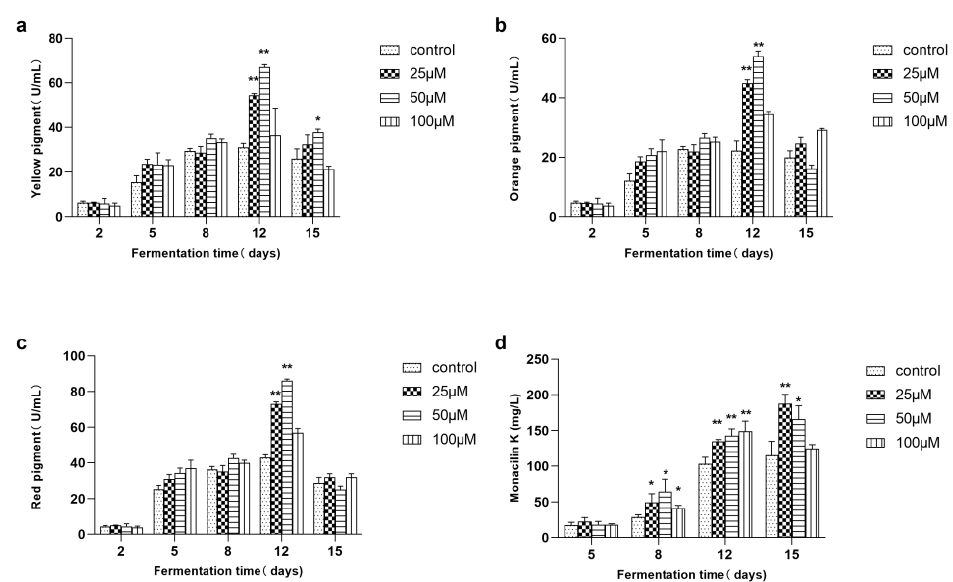
Figure 2. Effect of different γ -heptalactone concentrations on the yield of MPs and MK in M. purpureus M1. ( a ) Yellow pigment, ( b ) orange pigment; ( c ) red pigment, and ( d ) MK. Data are expressed as the mean ± SD ( n = 3). * p < 0.05 and ** p < 0.01, compared to the control.